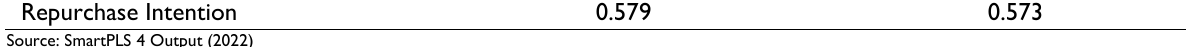
Table 7. R-Square R Square R Square Adjusted Repurchase Intention 0.579 0.573